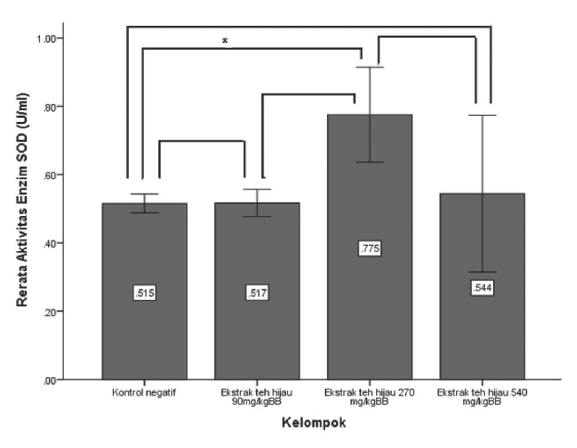
Figure 3. Scatter plot for the correlation between SOD enzyme activity (U/mL) and spatial memory function (percentage of time of probe